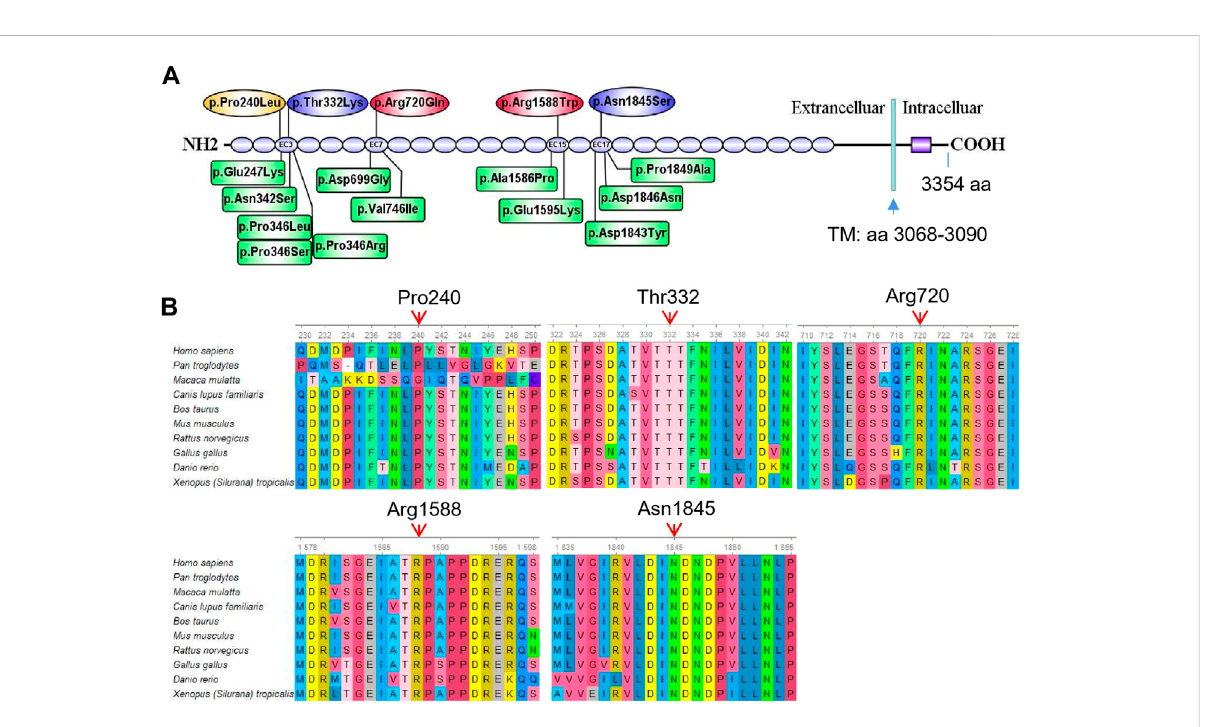
FIGURE 2 Mutation analysis of CDH23 . (A) Five different missense mutations identi fi ed in the fi ve affected individuals are mapped to the CDH23 protein. The spicing variant (c.7055-1G > C) in CDH23 is not shown in the CDH23 protein structure. As a comparison, 12 reported missense variants (HGMD) near the loci identi fi ed in the present study are also shown in green boxes. These missense variants are associated with nonsyndromic autosomal recessive deafness. Transmembrane domain (TM): amino acids 3,068 – 3,090. (B) All the fi ve variants are evolutionarily conserved as shown in multiple sequence alignment containing 10 different species from Xenopus to